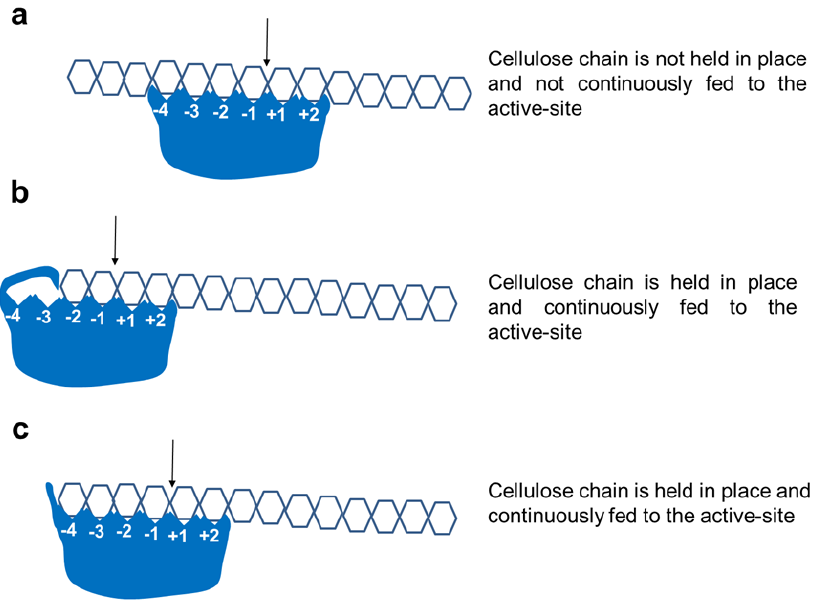
Figure 5. Various mechanisms of GH9 family cellulases found in algal enzymes. ( a ) Random cleavage of cellulose by endoglucanases to form oligosaccharides; ( b ) sequential cleavage of cellulose by GH9 exoglucanase-like enzyme due to partial blockage of the active site similar to that found in CbhA from Ruminiclostridium, 1UT9; ( c ) sequential cleavage of cellulose by processive endoglucanases (also called exo/endo cellulases) into oligosaccharides not longer than cellotetraoses due to blockage after the −4 binding site. Numbers ( −4 to +2) show binding subsites (non-reducing to reducing) in the cellulase catalytic domain (blue). Arrows show the cleavage site; hexagon, glucose units. Space-filled active-sites of algal and selected GH9 cellulases derived from homology models of CD were compared with the X-ray structures of endocellulases, an exoglucanase (both from GH6 and GH9 families), and mixed exo/endo processive endoglucanases (Figure 6). Binding and catalytic residues are shown as space-filled atoms, along with cellotetraose + cellobiose substrates (Figure 6b, top and lower panels). The X-ray structures of 4TF4 from T. fusca and 1KFG from C. cellulolyticum , with their respective oligosaccharides, were found to superimpose perfectly on each other, implying